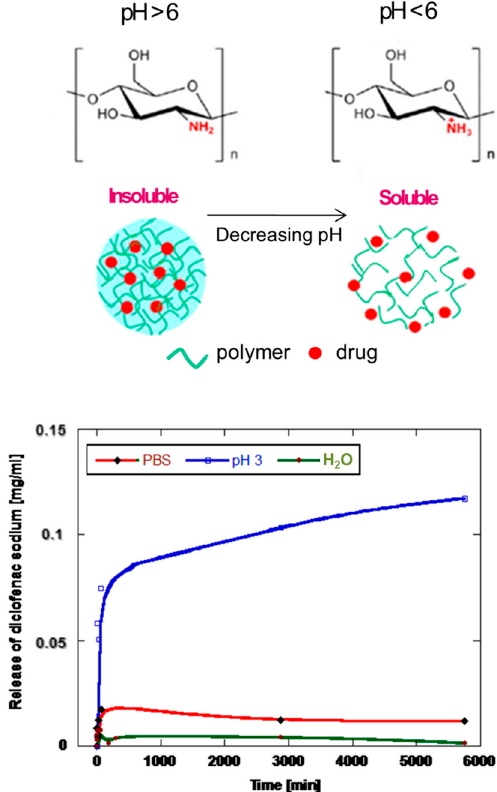
Figure 4. Release of sodium diclofenac from chitosan nanoparticles at different pH conditions.